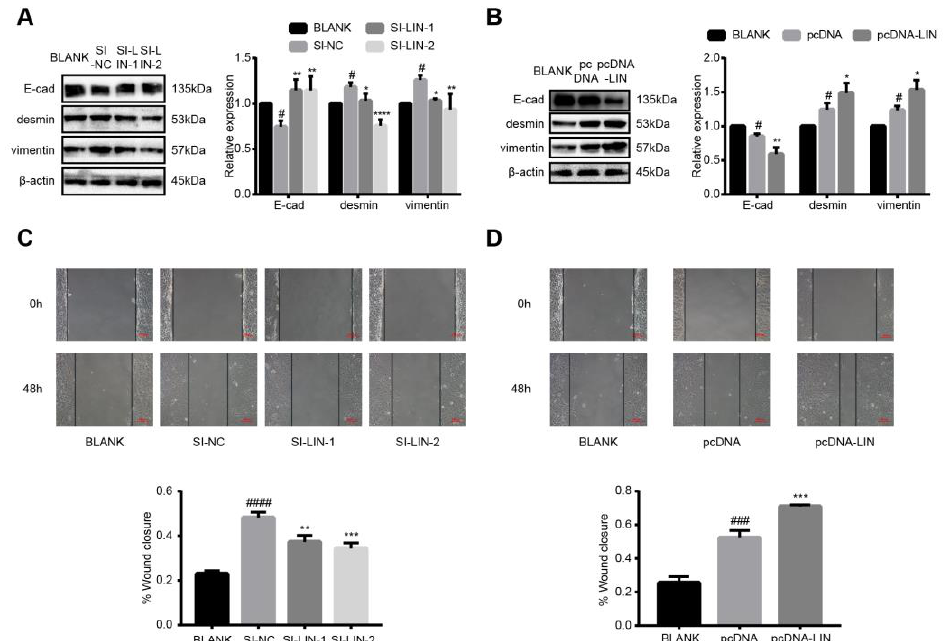
Figure 4. LINC00663 regulated EMT and migration of LX-2 cells. Relative expression of E-cadherin, desmin, and vimentin in LX-2 cells transfected with ( A ) si-LINC00663 (SI-LIN-1 and SI-LIN-2) and ( B ) pcDNA-LINC00663 (pcDNA-LIN) detected by WB. The effect of LINC00663 on cell migration in LX-2 cells transfected with ( C ) si-LINC00663 and ( D ) pcDNA-LIN detected by wound healing assay. Scale bar = 100 μm. * p < 0.05, ** p < 0.01, *** p < 0.001, **** p < 0.0001. # p < 0.05, ### p < 0.001, #### p < 0.0001. * vs. NC, # vs. BLANK. Each experiment was repeated three times and similar results were obtained. EMT, epithelial–mesenchymal transition; HSCs, hepatic stellate cells; si, small interfering RNA; WB, western blot.